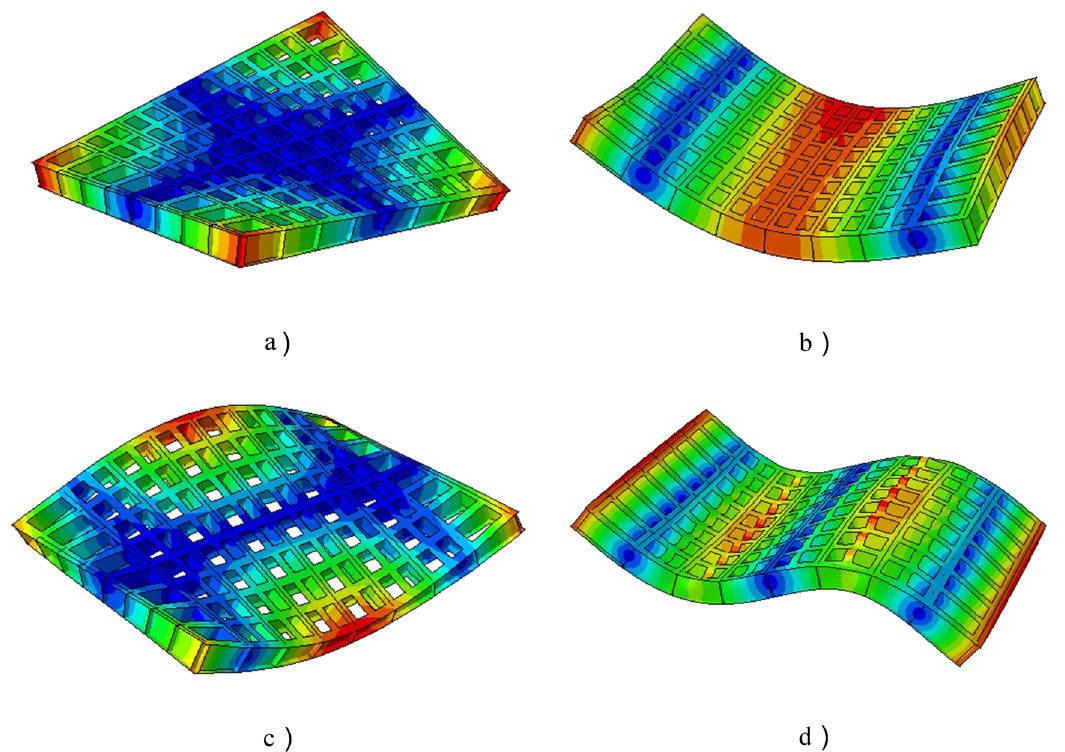
Figure 4: The modal of composite fl oating raft: ( a ) 1st - order torsional mode, ( b ) 1st - order bending mode, ( c ) 1st - order bending and torsion combined mode, and ( d ) 2nd - order bending